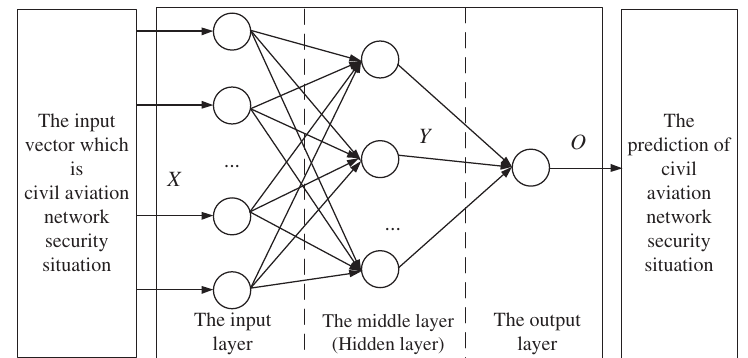
Figure 4. Model of Time-Series Forecasting Based on the WNN.